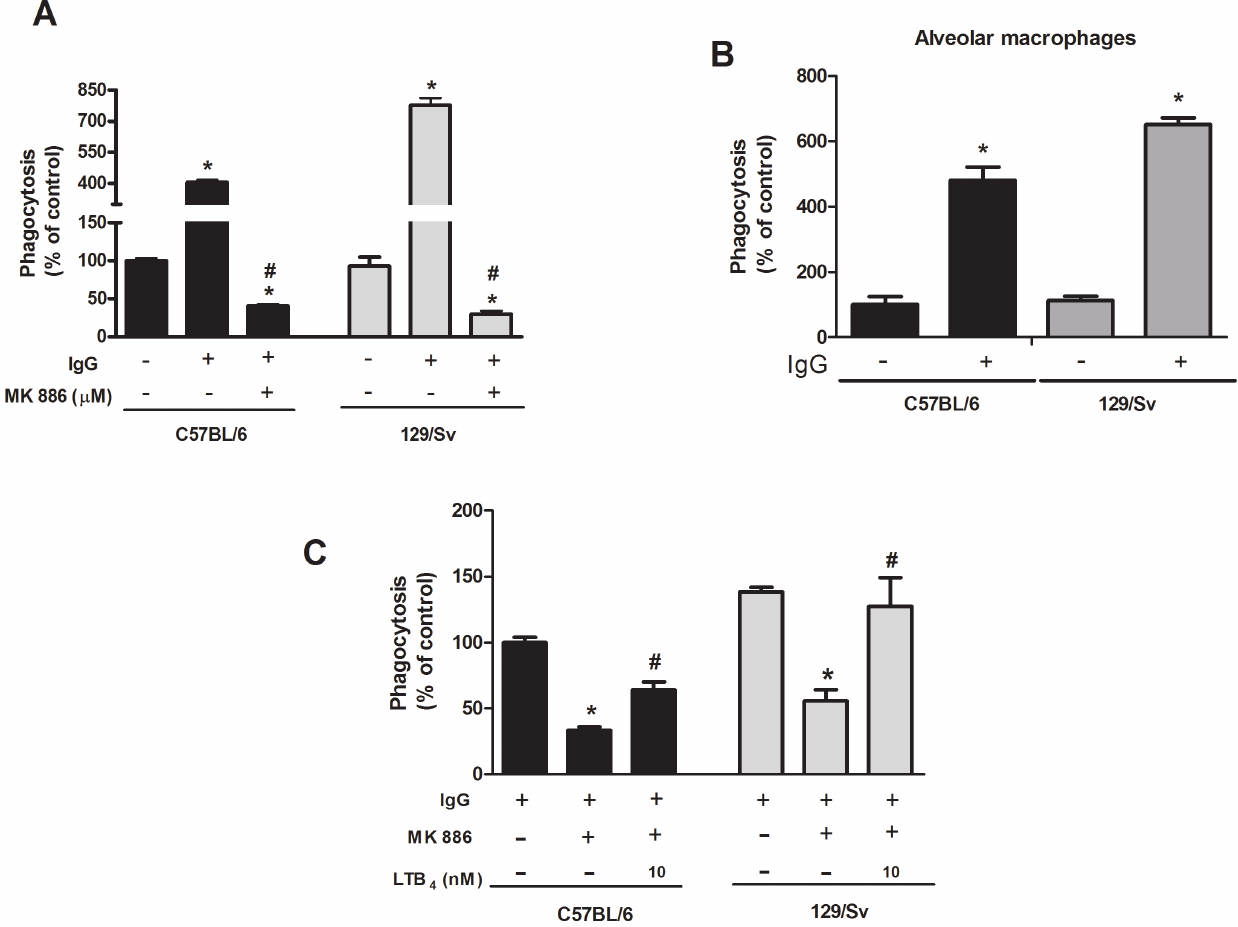
Figure 5. Effect of endogenous and exogenous LTB 4 on the phagocytosis of H.capsulatum by C57BL/6 and 129/Sv macrophages. PMs from C57BL/6 and 129/Sv mice were incubated for 2 h with IgG-opsonized or non-opsonized yeast cells at a yeast-to-cell ratio of 1:5. (A) PMs were pretreated with the LT synthesis inhibitor MK886 (1 m M) for 20 min. (B) AMs from C57BL/6 and 129/Sv mice were incubated for 2 h with IgG- opsonized or non-opsonized yeast cells at a yeast-to-cell ratio of 1:5. (C) PMs were pretreated with the LT synthesis inhibitor MK886 (1 m M) for 20 min, followed by challenge with LTB 4 (10 nm) for 5 min before the infection (C). The data are expressed as the mean 6 SEM from one representative experiment of a total of two experiments (n=3 to 5). *sv129 compared with C57BL/6. # sv129 and C57BL/6 compared with MK886/LTB 4